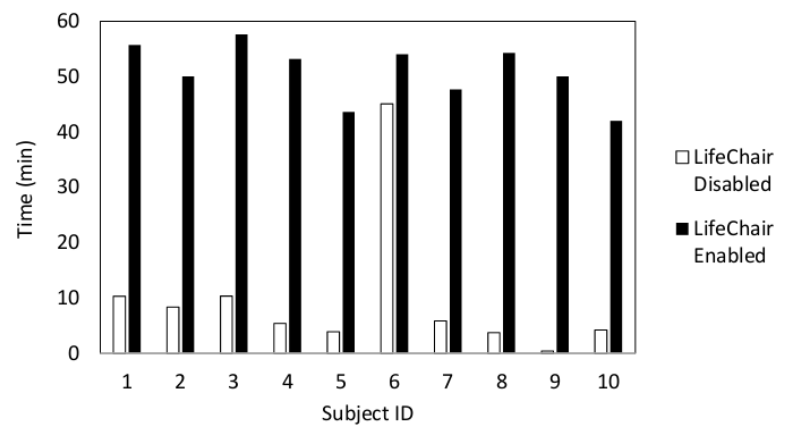
Figure 9. Vibrotactile feedback effect on posture: upright posture response for all 10 participants when LifeChair was disabled and enabled.